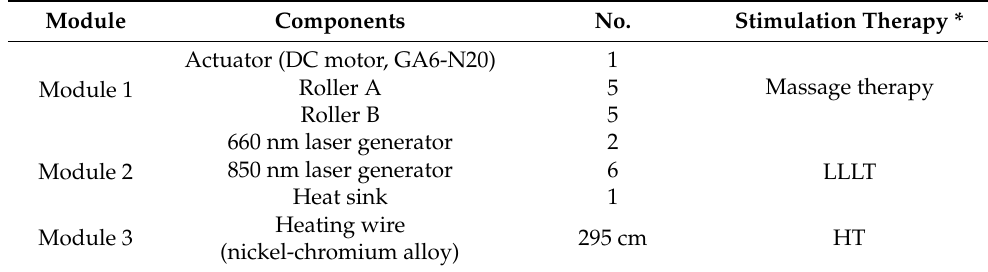
Table 1. Module and physiotherapy system (CUHK-OA-M2).